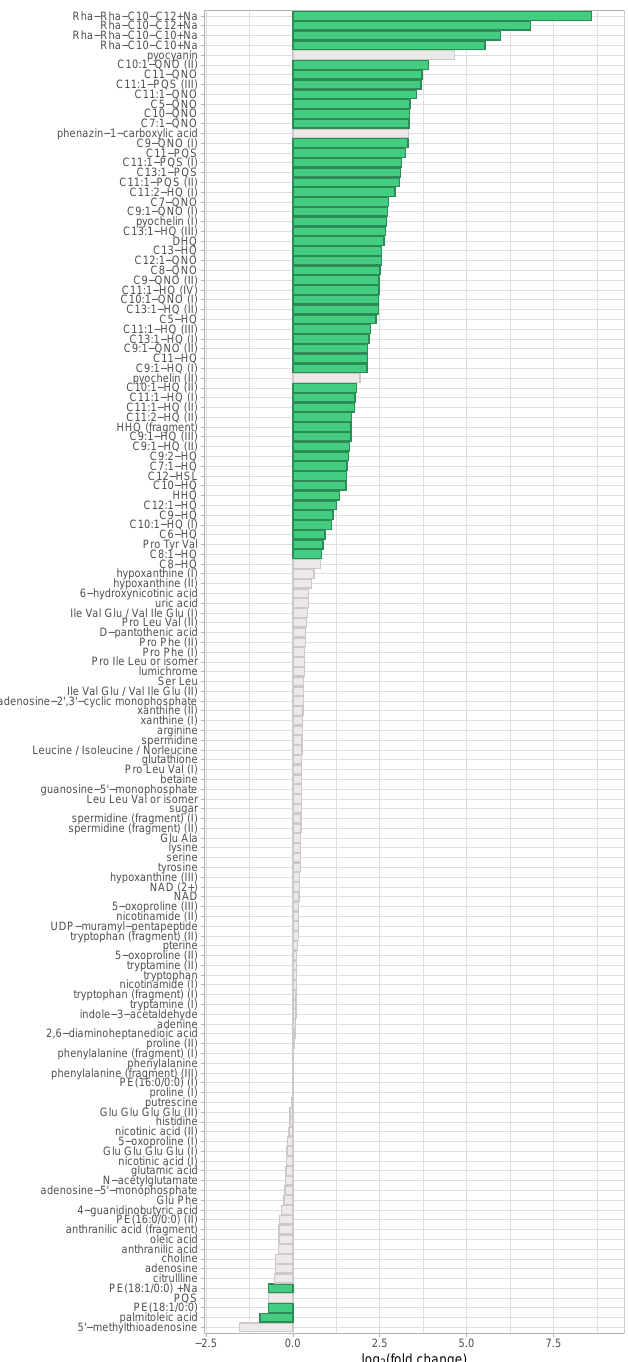
Figure 2. Regulation of identified metabolites in the discovery data set. The binary logarithm of their (non-directional) fold change was plotted on the x-axis for all identified metabolites. Features exhibiting a fold change ≥ 1.5 and a corrected p -value ≤ 0.05 were coloured in